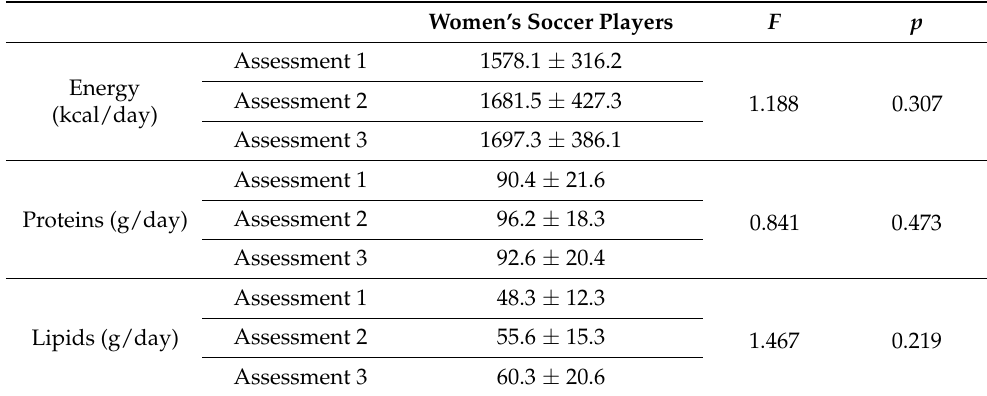
Table 4. Nutritional